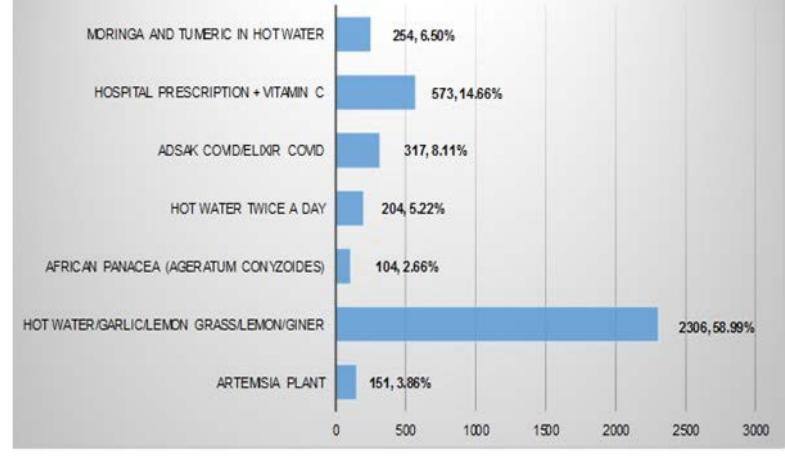
Figure 3. Traditional herbal remedies used to control COVID-19 infection.